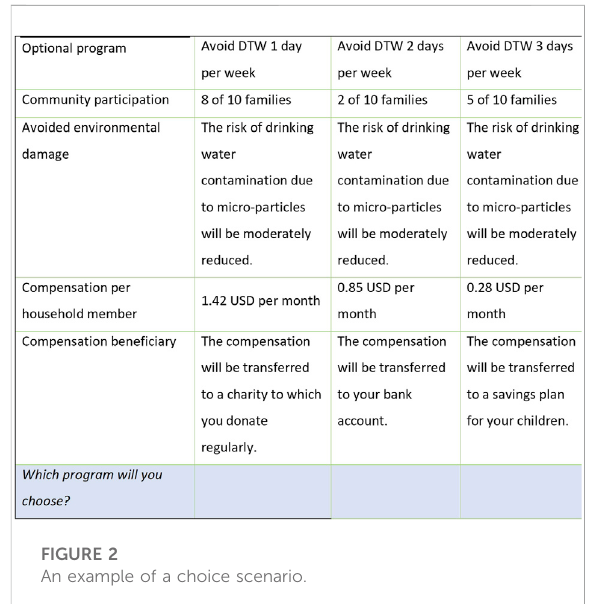
FIGURE 2 An example of a choice